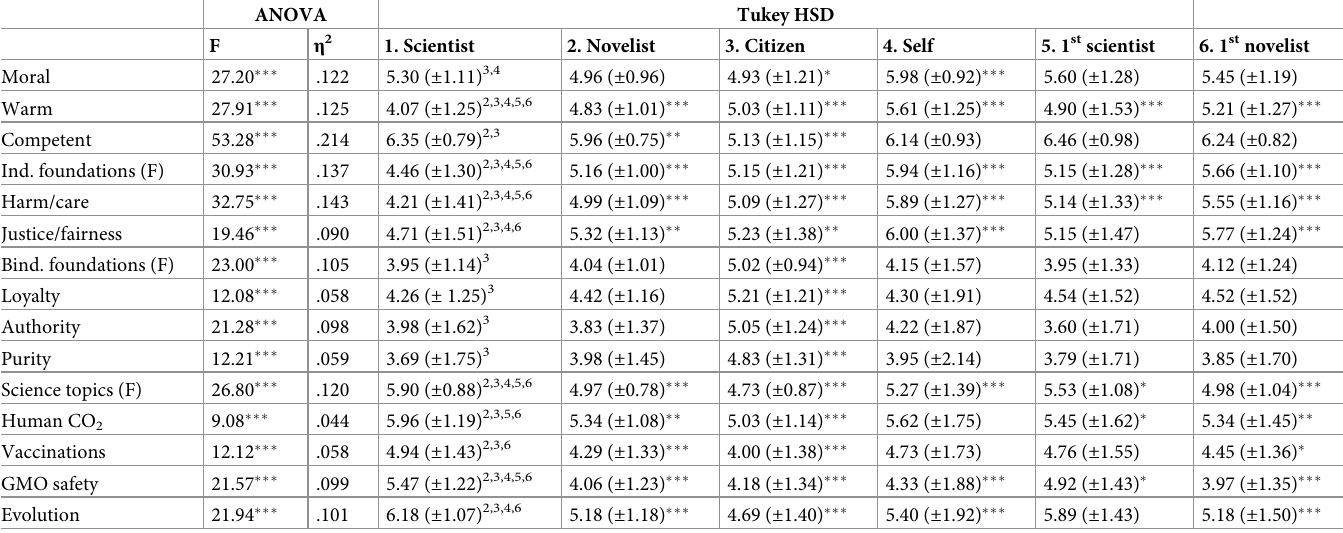
Table 2. Means and standard deviations for all groups and results of ANOVA and Tukey HSD